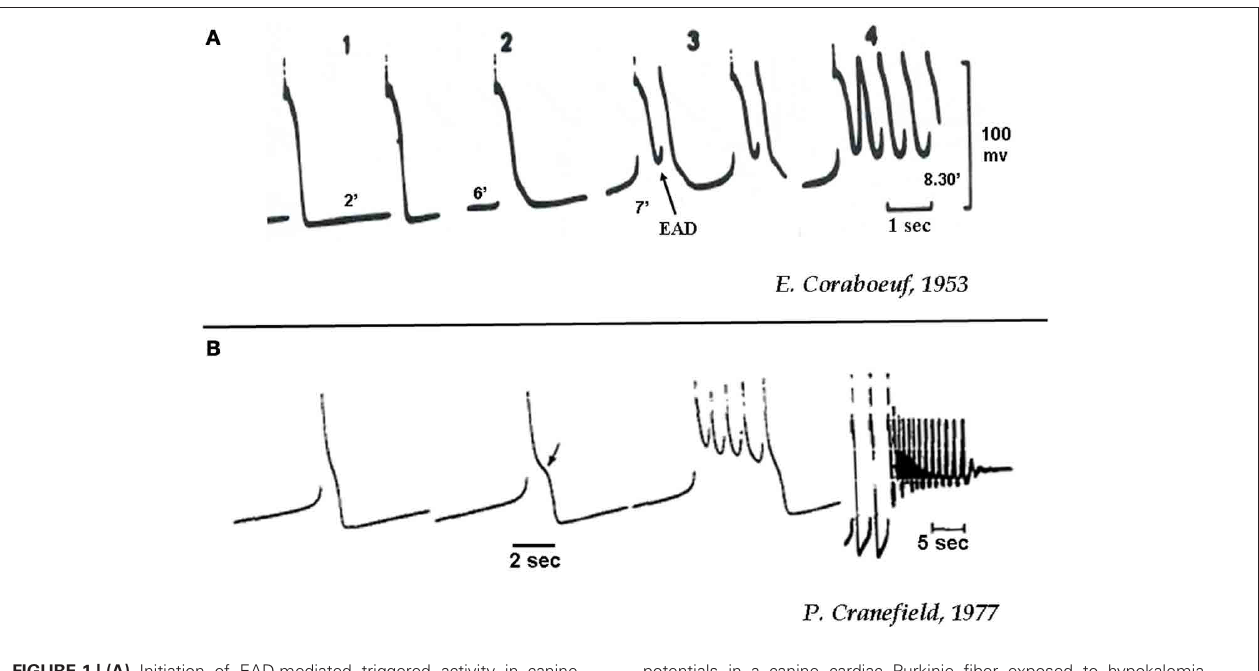
FIGURE 1 | (A) Initiation of EAD-mediated triggered activity in canine cardiac Purkinje fibers during acidosis (A) and hypokalemia (B) . (A) The numbers 1–4 indicate progressive increase in the duration (2, 5, 7, 8.5min) of acidosis (20% CO 2 and 80% O 2 ) as shown below each recording [from Corabeuf, 1953 (Coraboeuf and Boistel, 1953)]. (B) Action